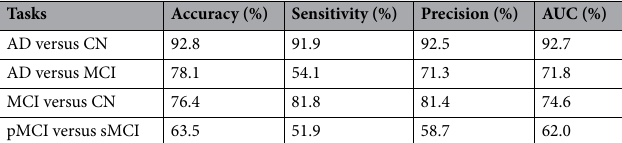
Table 5. Results of the proposed method in four binary classification tasks.